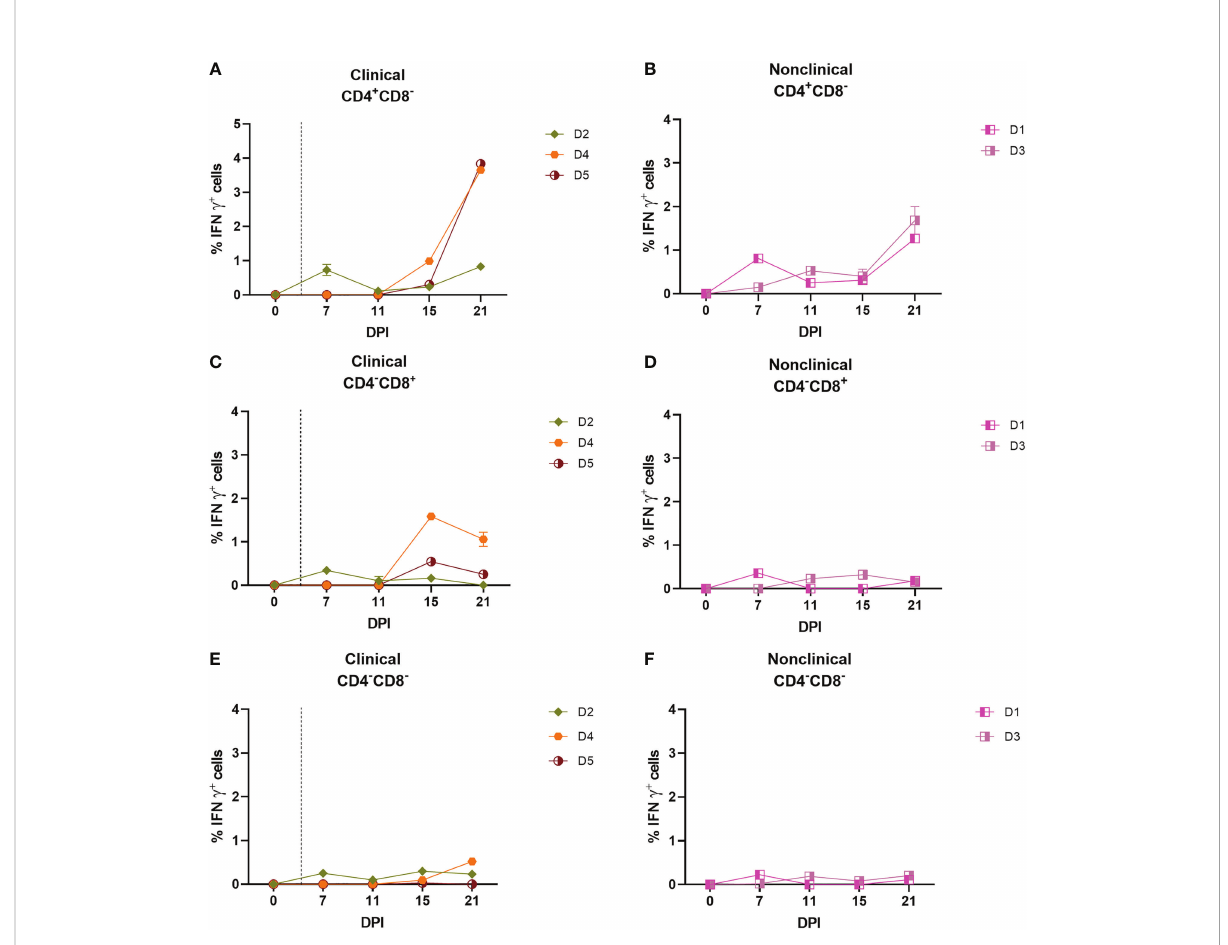
FIGURE 4 CD4 + CD8 – and CD8 + CD4 – but not CD4 – CD8 – T cells are responsible for the production of IFN – g in response to stimulation with UV – inactivated LSDV in needle – inoculated calves. Flow cytometric analysis was used to determine the % of IFN – g + T cells expressing CD4 + CD8 – (A, B) , CD8 + CD4 – (C, D) and CD4 – CD8 – (E, F) in response to stimulation with SW – UV inactivated LSDV. Samples were tested in triplicate and normalised to the mock control. The error bars represent the SEM. The dotted vertical line represents the fi rst day lesions occurred in clinical animals. Data corrected to mock PBS